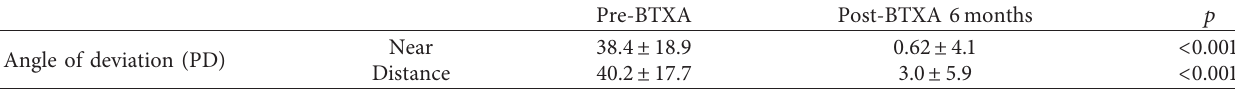
Table 4: Pre- and Post-BTXA 6months comparison in patients with AACE.